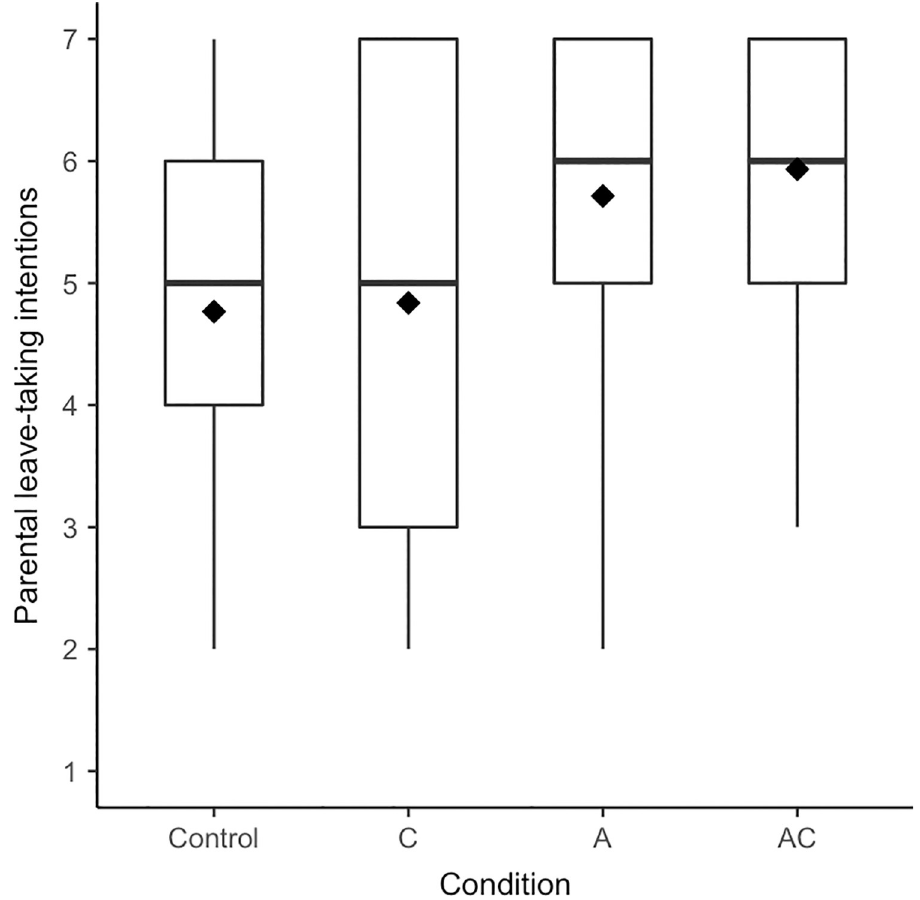
Fig 1. Boxplots for parental leave-taking intentions separated by condition (Experiment 1). Diamonds represent means, horizontal lines represent medians.